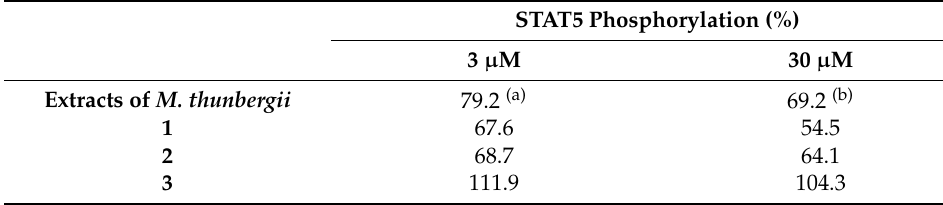
Table 1. The effect of isolated compounds on STAT5 phosphorylation by flow cytometry. STAT5 Phosphorylation (%)